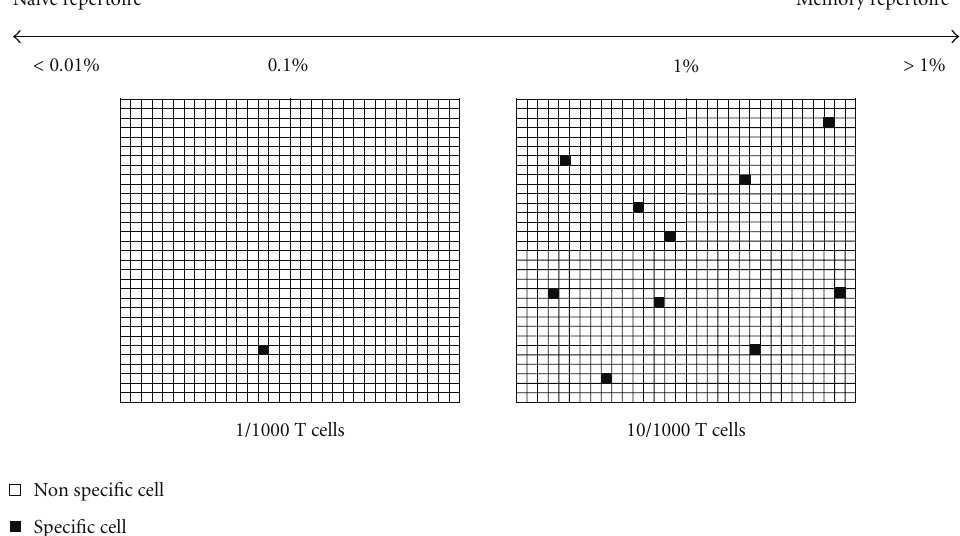
Figure 3: Frequency of specific T cells and culture size. The frequency of antigen specific T cells must be kept in mind when scaling down culture conditions. Reasonable frequencies for specific T cells approximately range from > 1% to < 0.1% for memory responses to recall protein antigens. Responses to individual epitopes may be at lower frequencies. Frequencies of specific T cells in the na¨ıve repertoire may be < 0.01%. Panels represent 1000 lymphocytes containing 1 specific cell (0.1%, left panel) or 10 specific cells (1%, right panel). In case 1000 cells containing 1 specific cell are seeded in a microwell, the specific T-cell may or may not be dispensed according to Poissonian distribution and the signal provided by one single cell may not be detected. In case 1000 cells containing 1% specific cells are seeded, 10 specific cells can provide a detectable positive signal. Therefore, it can be assumed that the smallest number of cells per well should be > 10 3 cells. This reasoning applies to any T-cell assay adapted to 384 or 1536 well plates. Obviously, for very low frequency responses, more cells need to be seeded, but in this case the intrinsic sensitivity of the assay should be checked to establish a frequency threshold. Unfortunately, reliable cellular standards are not available, unless established antigen specific T-cell lines are used, as discussed in